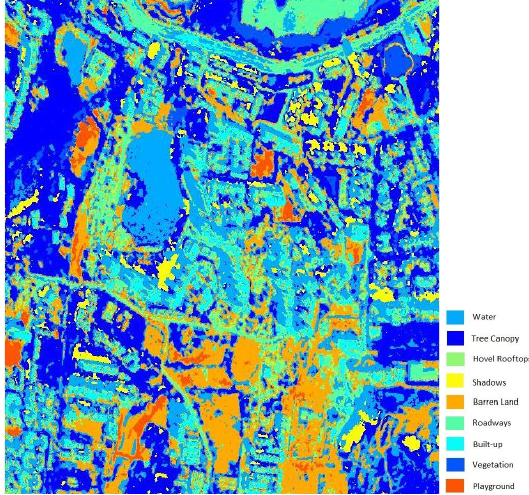
Figure 2: Classified output using single classifier